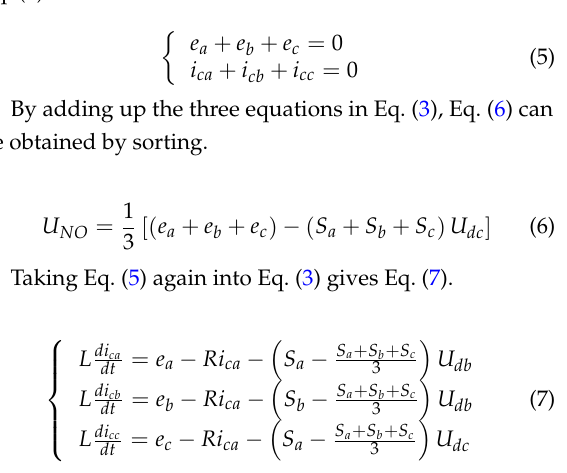
Fig. 3. Relationship between main circuit operating mode and switching